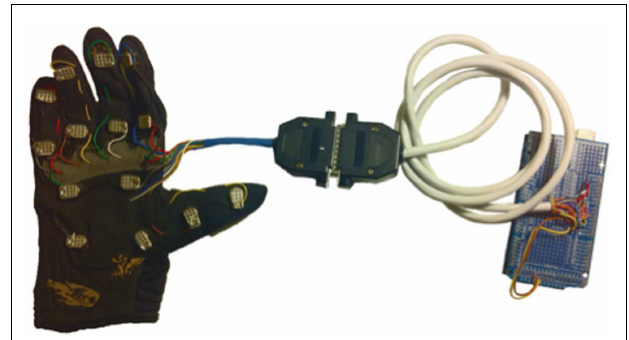
FIGURE 5 |AVibroGlove to deliver a sensation of touch to the hands . Here we show a glove with 14 vibrotactile actuators controlled by an Arduino